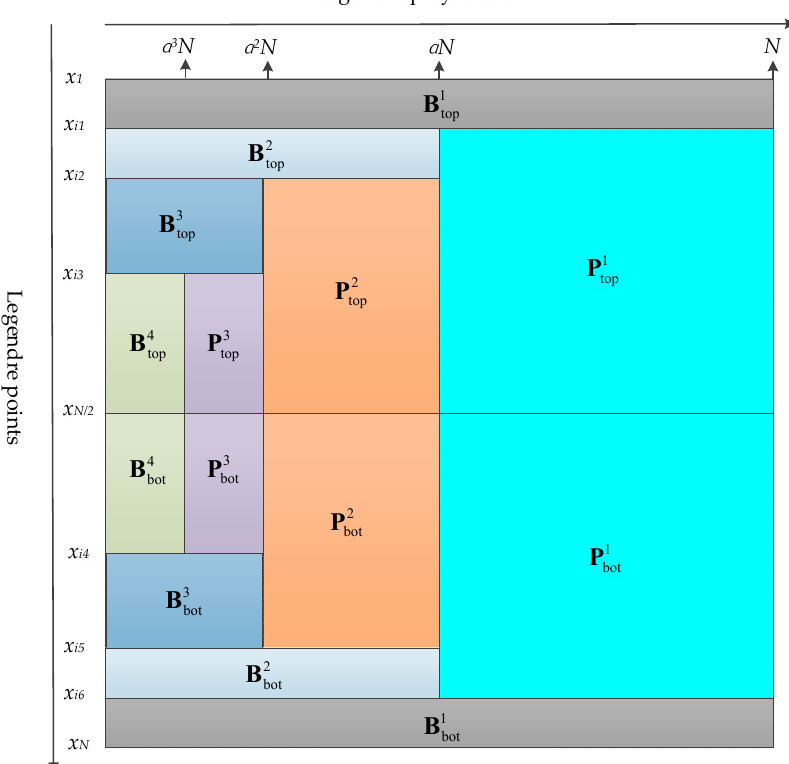
Figure 1. Partitioning of the Legendre-Vandermonde matrix for N = 1024 (in which matrix B is the boundary parts can’t be accurately expressed by the asymptotic formula while matrix P is the internal parts can. There are 2( K + 1) sub-matrices of B and 2 K sub-matrices of P . According to the symmetric or anti-symmetric property of Legendre polynomials, we only need to consider K + 1 sub-matrices of B and K sub-matrices of P on top).